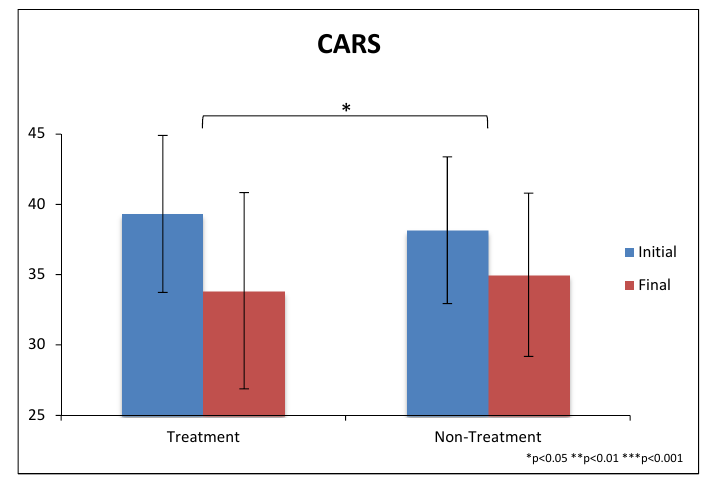
Figure 4. CARS ‐ 2 scores at beginning and end of the study. The scale goes from 15 to 60, with scores of approximately 27 and above being the cut ‐ off for ASD. Error bars represent standard deviations.